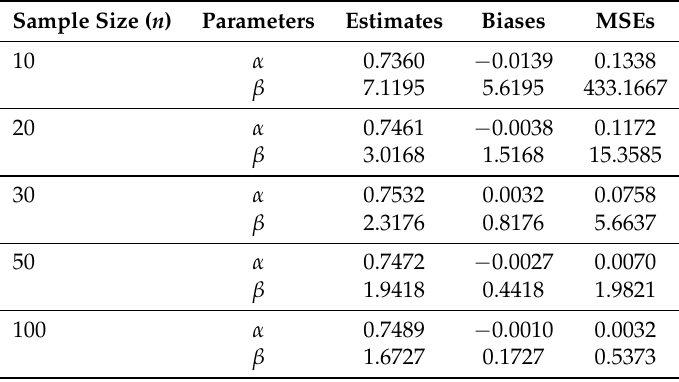
Table 3. Estimates, biases and MSEs for α = 0.75 and β =